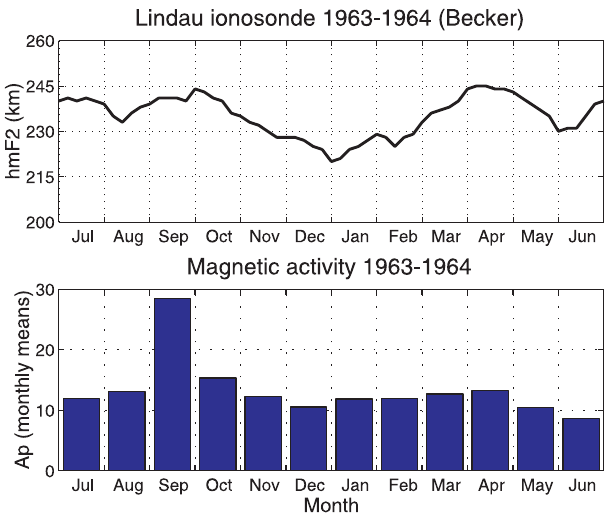
Fig. 1. Plot of h mF2 at Lindau (52 (cid:176) N), as derived from ionograms by Becker (1967), and the geomagnetic index A p for the 12-month